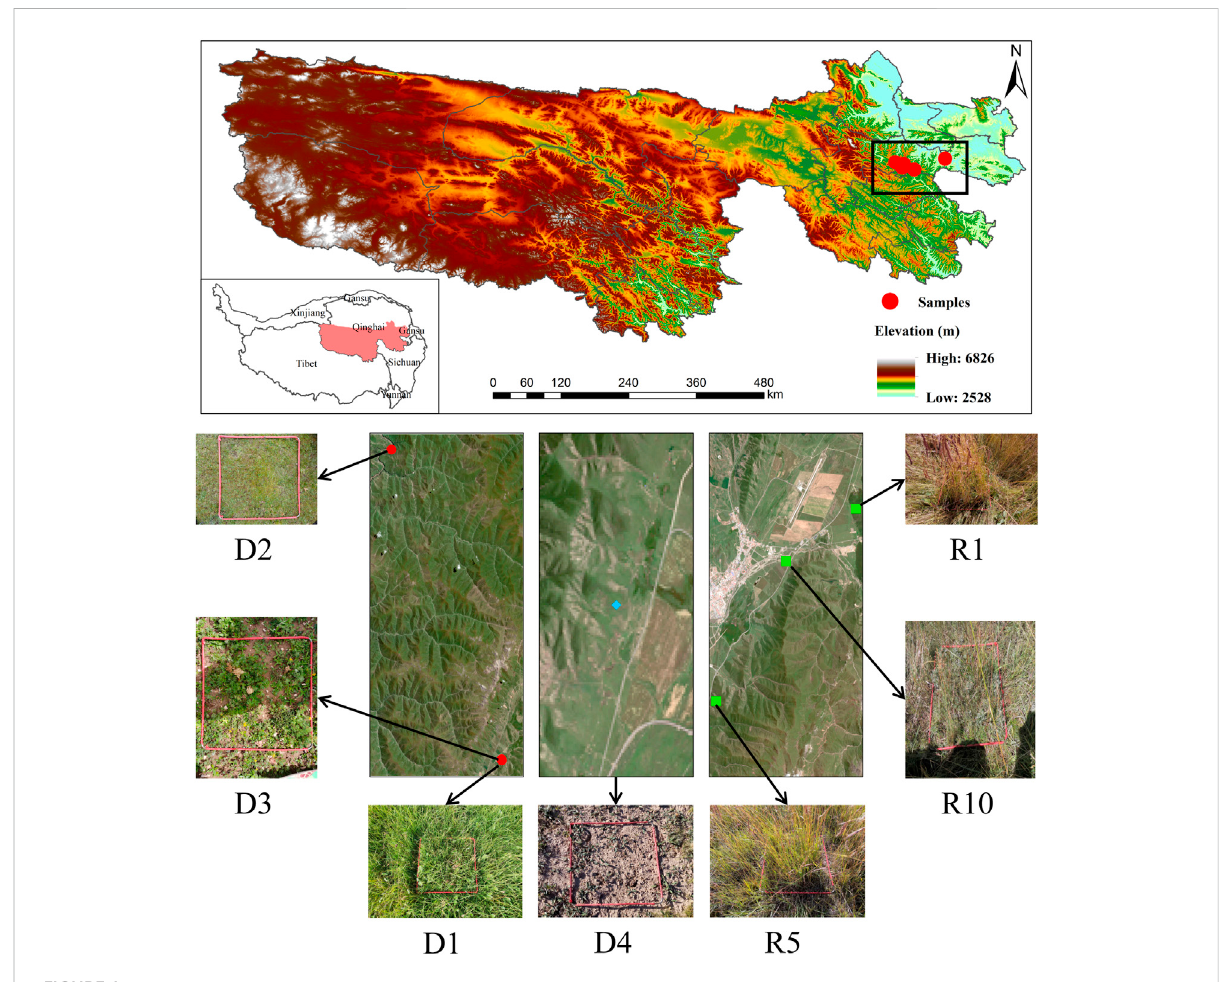
FIGURE 1 Schematic diagram of the location of the study